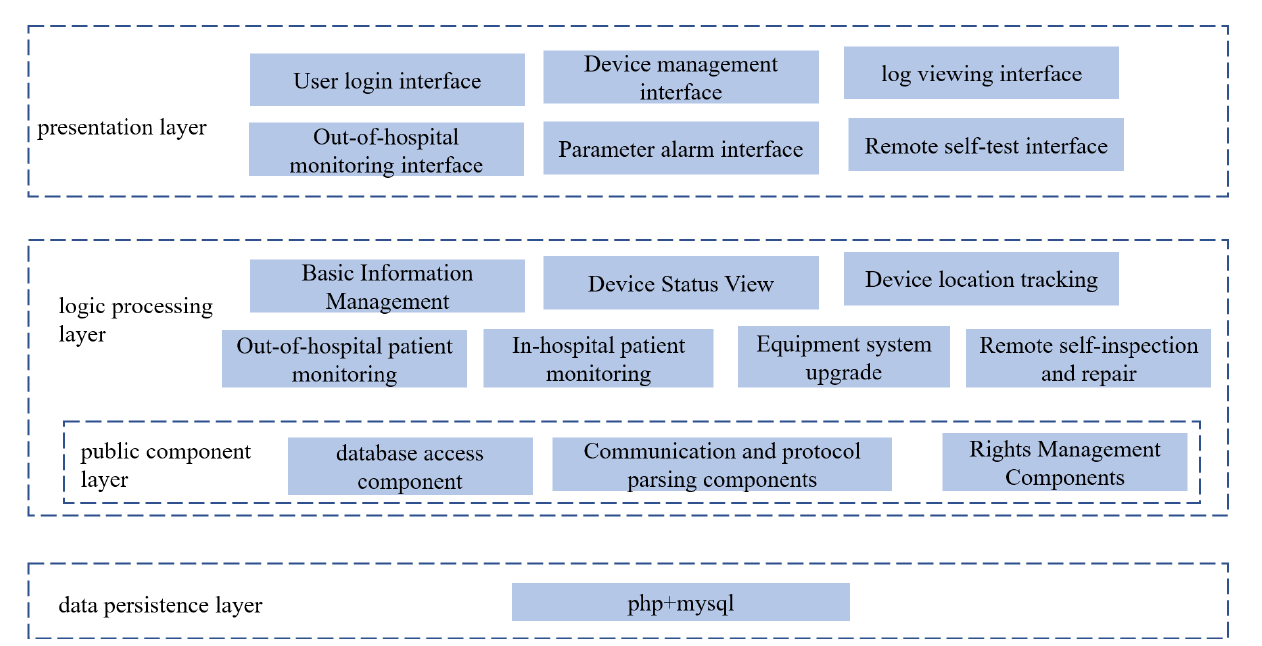
Figure 2. System internal hierarchy